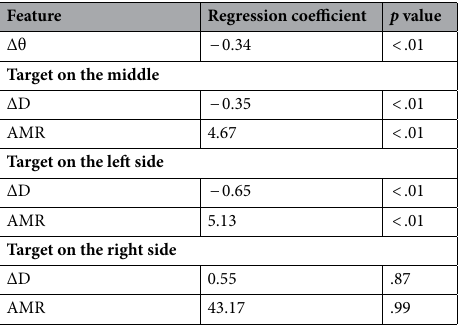
Table 2. Regression coefficient and p -values for univariate regression analysis.